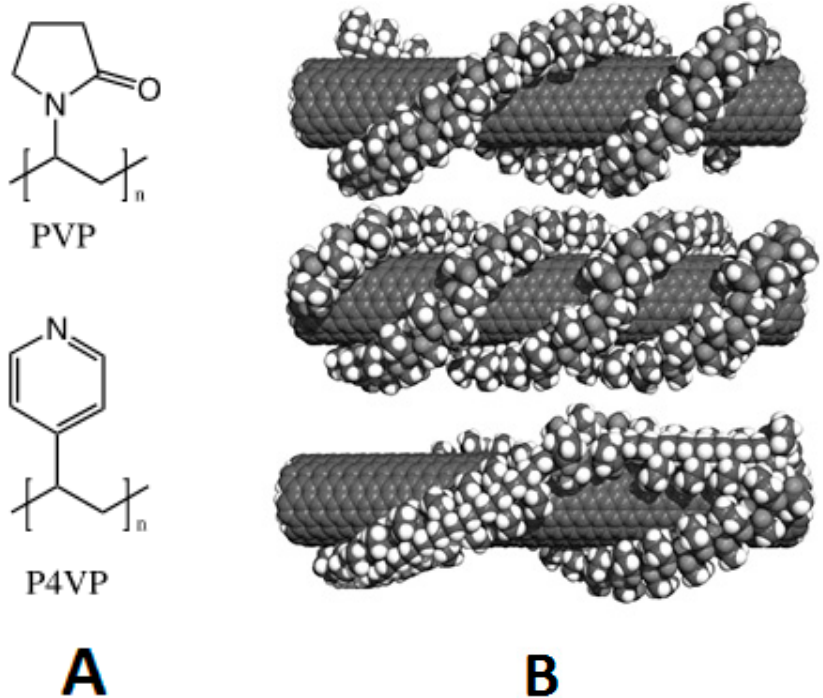
Figure 1. ( A ) Structure of PVP and P4VP; ( B ) computer model of PVP wrapping arrangement on a carbon nanotube [15].